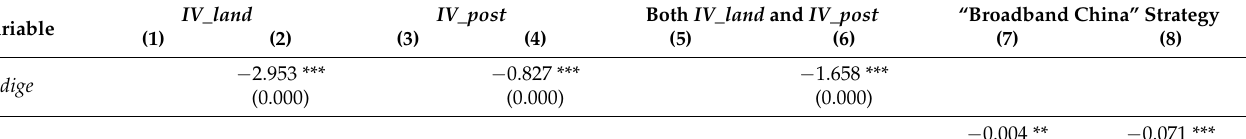
Table 7. Endogeneity test